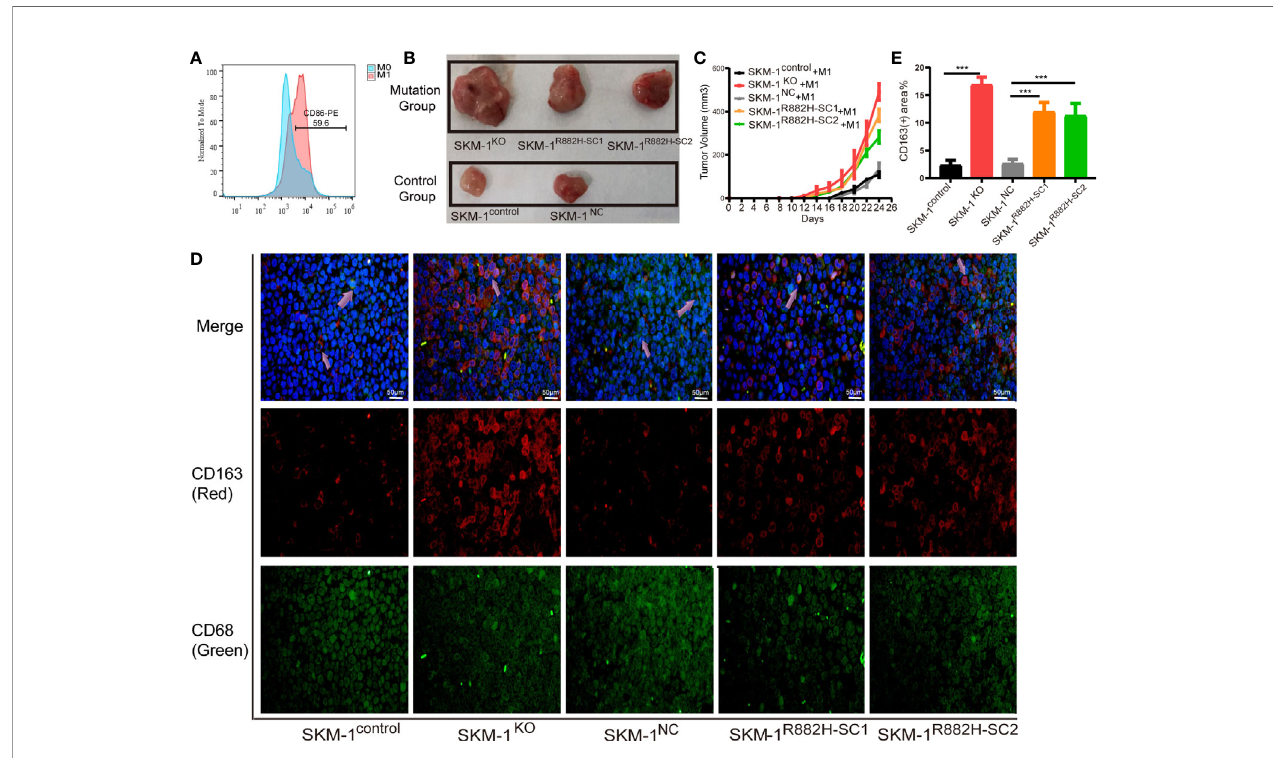
FIGURE 4 | DNMT3A-mutated AML cells attenuated M1 macrophage polarization and resist its killing effect in vivo . (A) The expression of CD86 in M0 macrophages after stimulation with Lipopolysaccharide (LPS). (B, C) The tumor volume of the experimental and the control group after the co-culture with M1 macrophages in vivo , n = 3. (D) Immuno fl uorescence showed the number of CD68+CD163+ double-positive cells (M2 macrophages) in fi ltrating the tumor tissue. CD68 (macrophage marker) in green, CD163 (M2 marker) in red, nuclei in blue, and the purple arrow points to M2 macrophages. (E) Statistical graph of CD163-red fl uorescence intensity. All the results are presented as mean ± standard deviation of three independent experiments (n = 3). ***p < 0.0001 represent signi fi cant differences compared with the